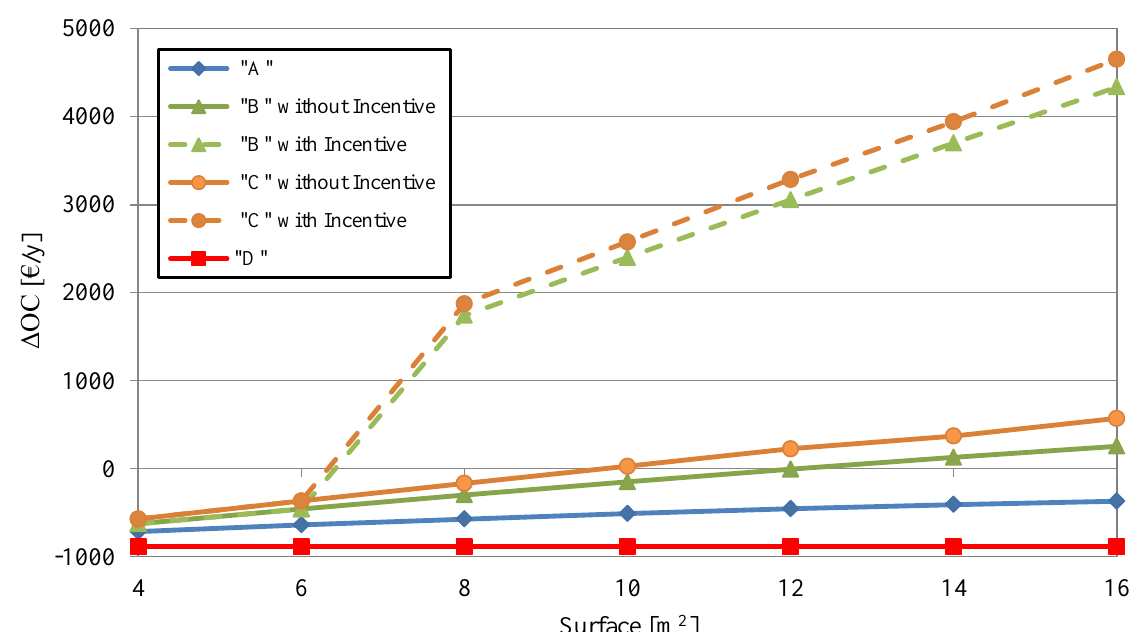
Figure 10. Differences of the annual operating costs between the four scenarios considered and the RS with and without incentives. Scenarios A (air collectors), B (flat-plate collectors, with and without incentive), C (evacuated tube collectors, with and without incentive), D (natural gas